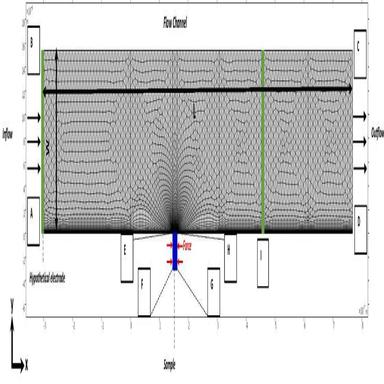
A schematic of the fluid channel and sample in the model. The green vertical lines mark the positions of the hypothetical electrodes. The letters are primarily used to assign boundary conditions, and their details can be found in